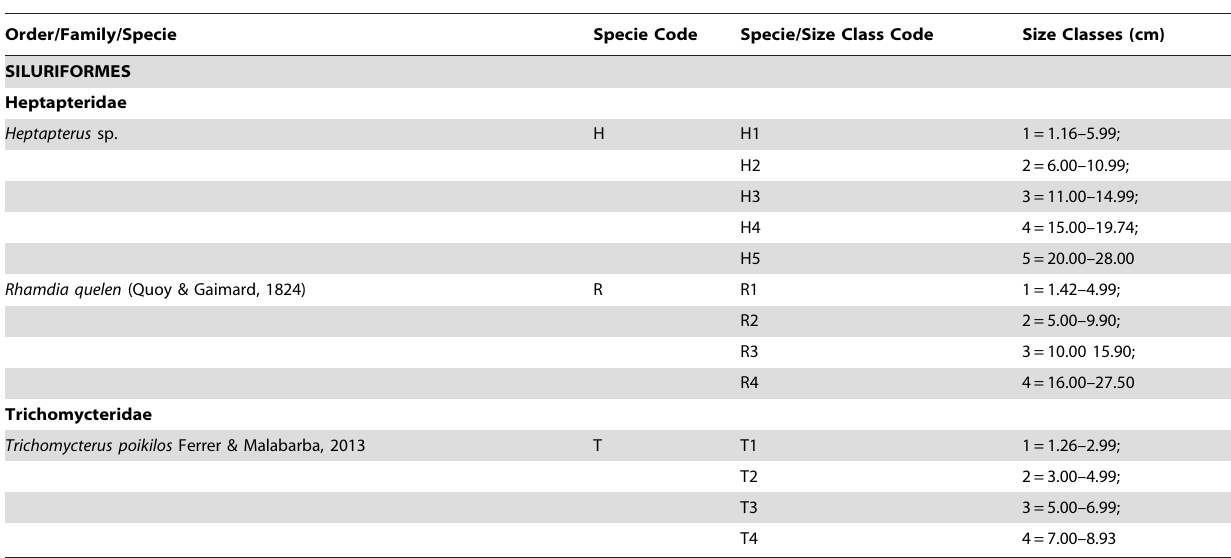
Table 1. Taxonomic position of three species in the Alto Jacuı´ sub-basin.